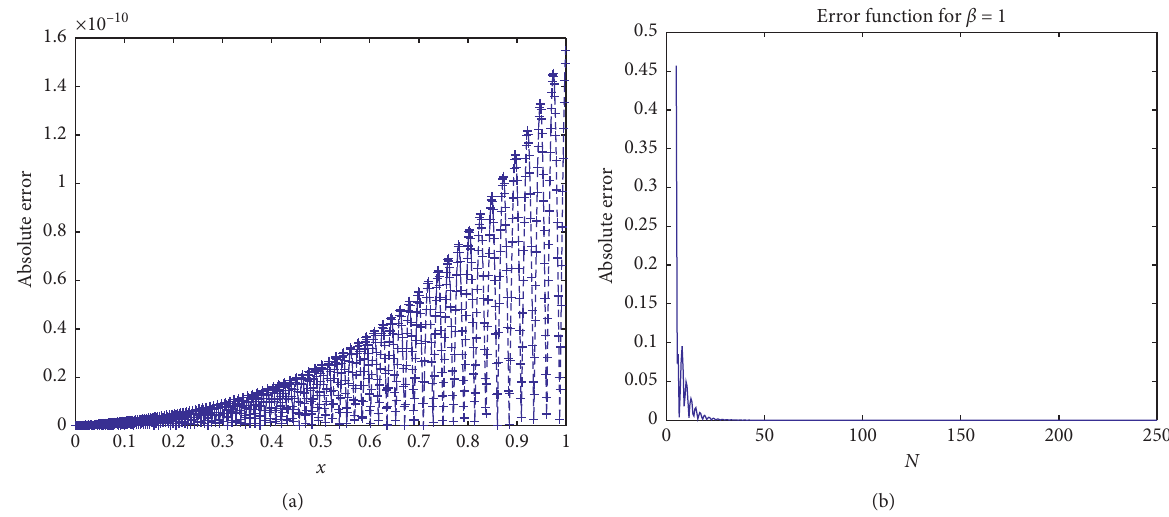
Figure 4: (a) The absolute error at x � 1 and β � 1 for Problem 2. (b) The error function for β � 1 and various quadrature nodes corresponding to Problem 2.